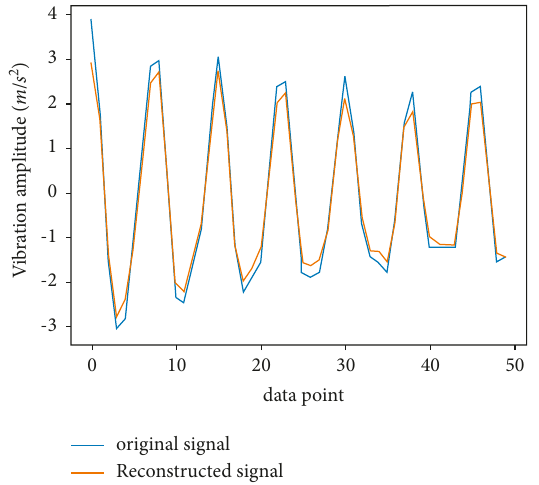
Figure 11: Normal signal reconstruction